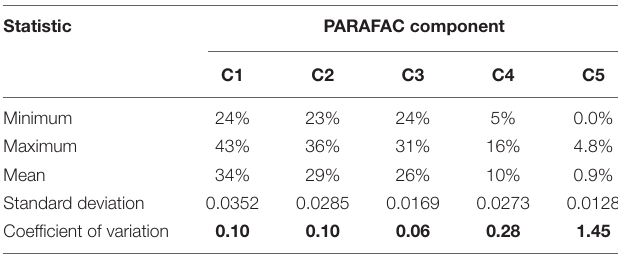
samples, during March and May